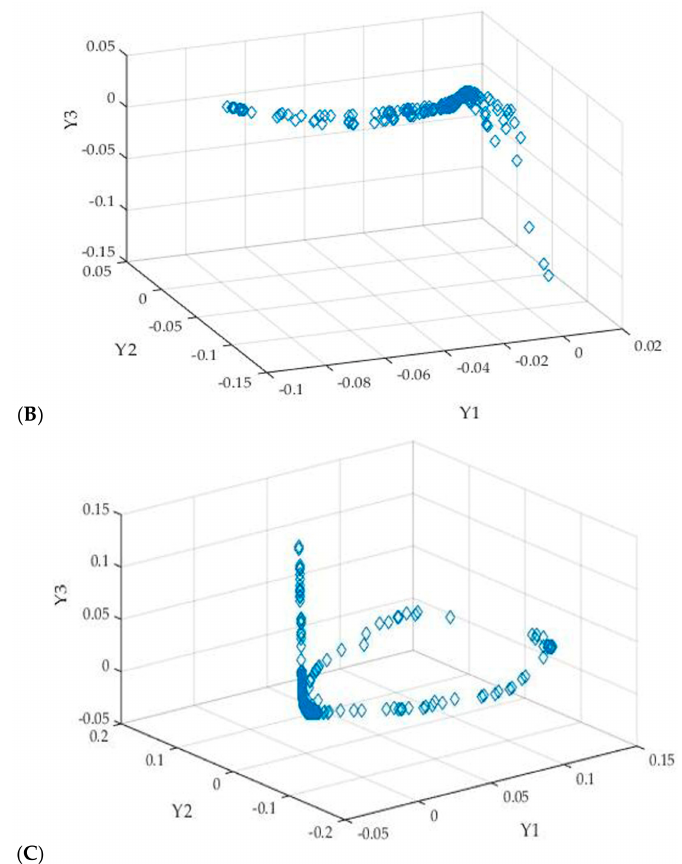
Figure 4. The first three coordinates of diffusion coordinates. ( A ) DM calculated with all of the image data. ( B ) DM calculated with sampled image data, where the random sampling rate is 0.8. ( C ) DM calculated with sampled image data, where the random sampling rate is